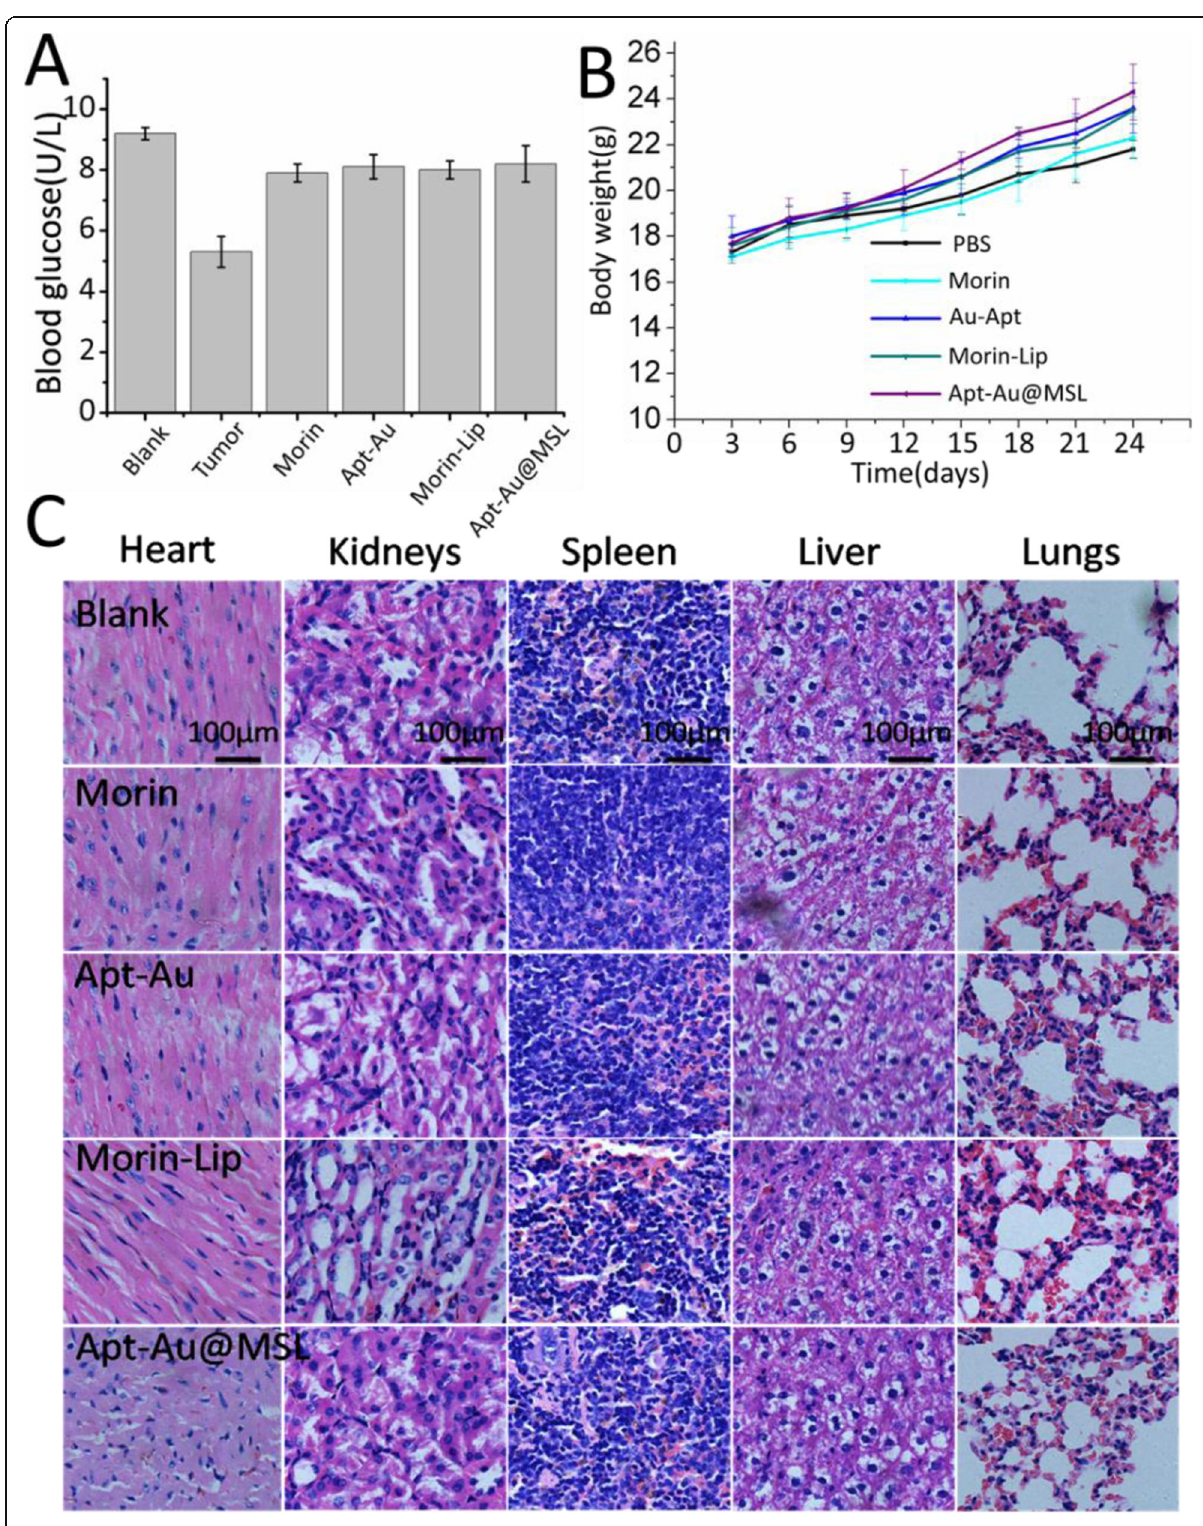
Fig. 11 In vivo toxicity evaluation. a Blood glucose data detected in the mouse toxicity model. b Weight of mice in different groups after 24 days. c Images of H&E-stained major organs. Each value represents the mean ± SD ( n =